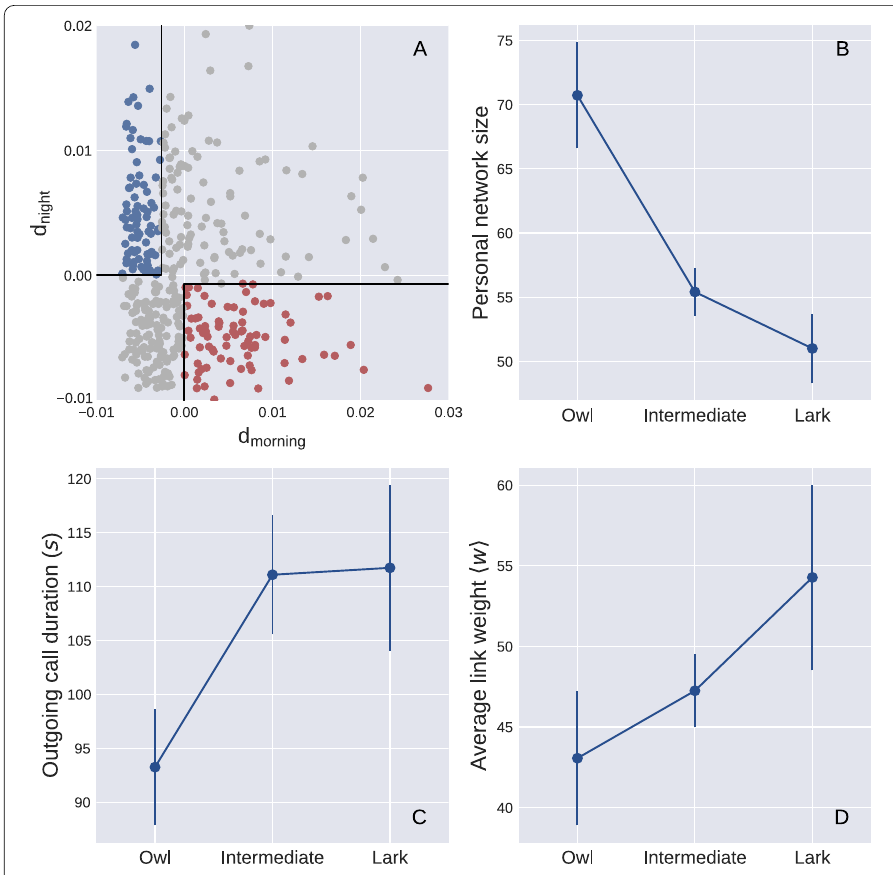
Figure 2 Chronotypes and their behavioral differences. Panel ( A ) displays the criteria for labeling participants as night-active owls (blue) and morning-active larks (red). x - and y -axes represent the difference between morning patterns and evening patterns of each individual’s activity compared to the population average activity rhythm, respectively. Panels ( B ), ( C ), ( D ): Average personal network size, average duration of